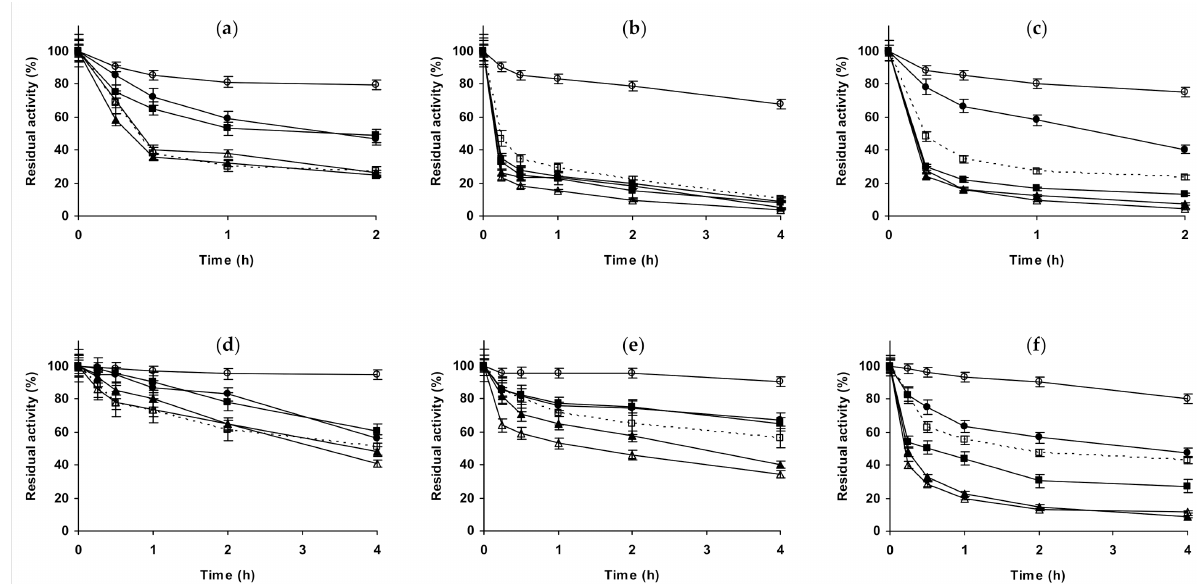
Figure 3. Effect of ionic strength and inactivation pH on the stability of different immobilized preparations of CRL. Octyl- CRL: ( a ) pH 5.0 and 65 ◦ C; ( b ) pH 7.0 and 64 ◦ C; ( c ) pH 9.0 and 40 ◦ C. Glutaraldehyde-CRL: ( d ) pH 5.0 and 68 ◦ C; ( e ) pH 7.0 and 67 ◦ C; ( f ) pH 9.0 and 40 ◦ C. Other specifications are described in the Methods section. Dotted line, empty squares: references; full triangles: 1 M NaCl; empty triangles: 3 M NaCl; full circles: 1 M (NH 4 ) 2 SO 4 ; empty circles: 3 M (NH 4 ) 2 SO 4 and full squares: 1 M Na 2 SO 4